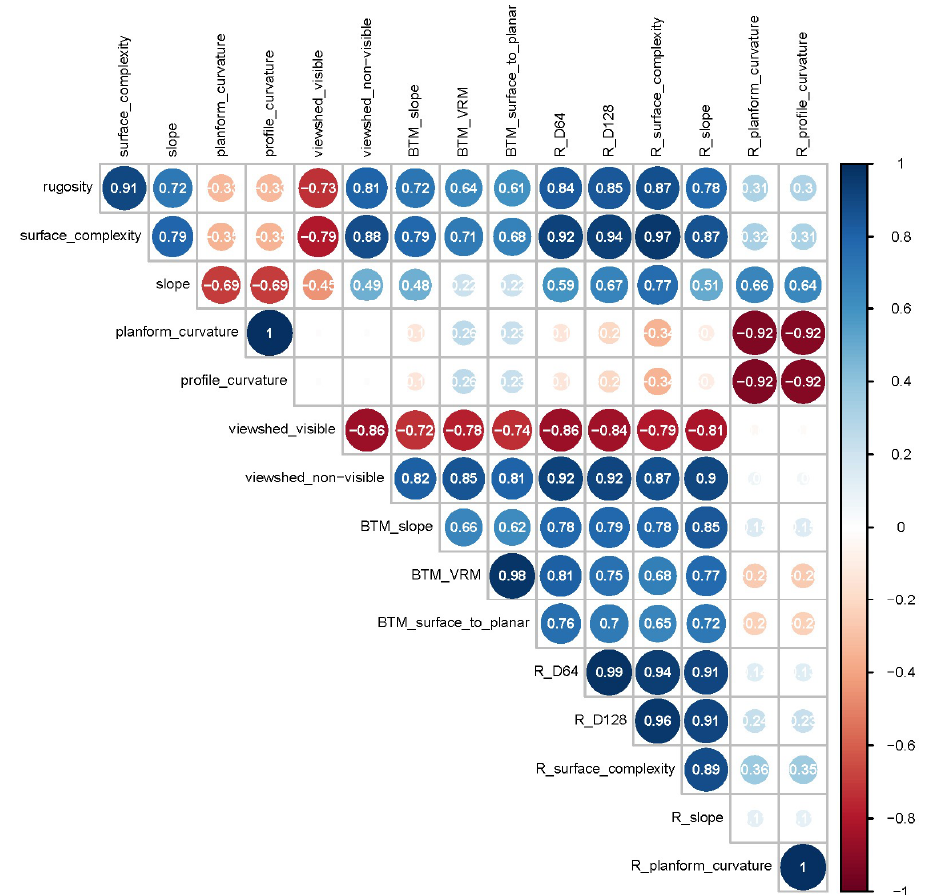
Figure 2. Pearson correlation coefficients ( ρ ) between habitat metrics obtained using the ArcMap path distance toolset, ArcMap surface toolset, ArcMap BTM and R.